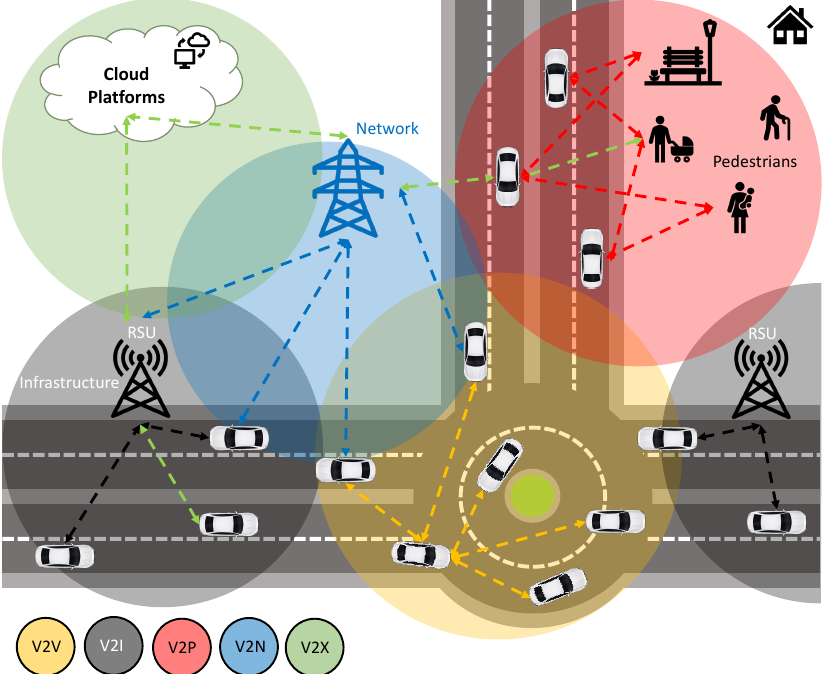
Figure 5. Communication technologies for CCAM Infrastructure to enable L-5 autonomous